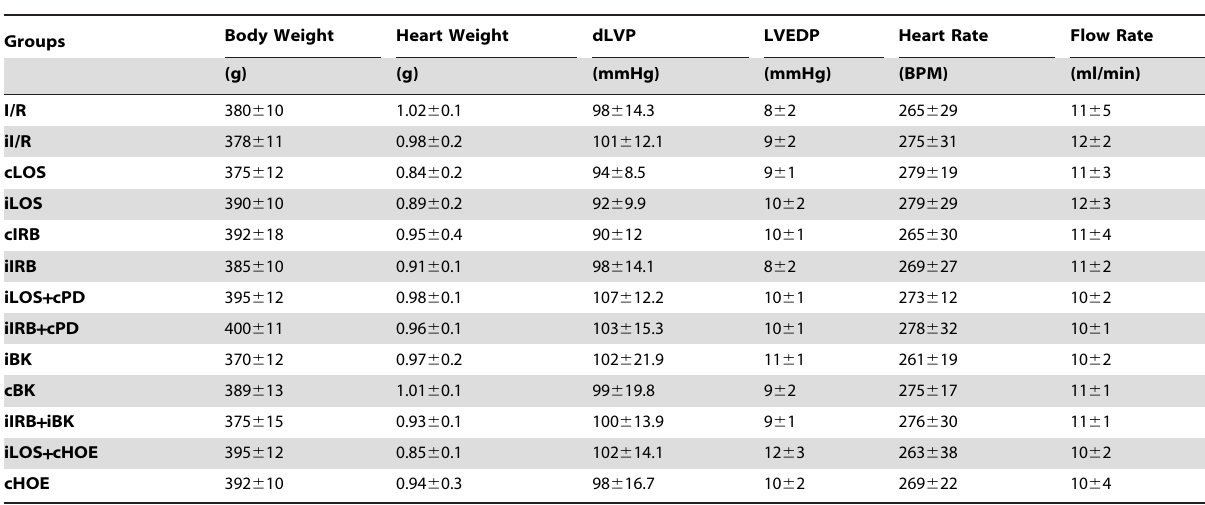
Table 1. Hemodynamic parameters at